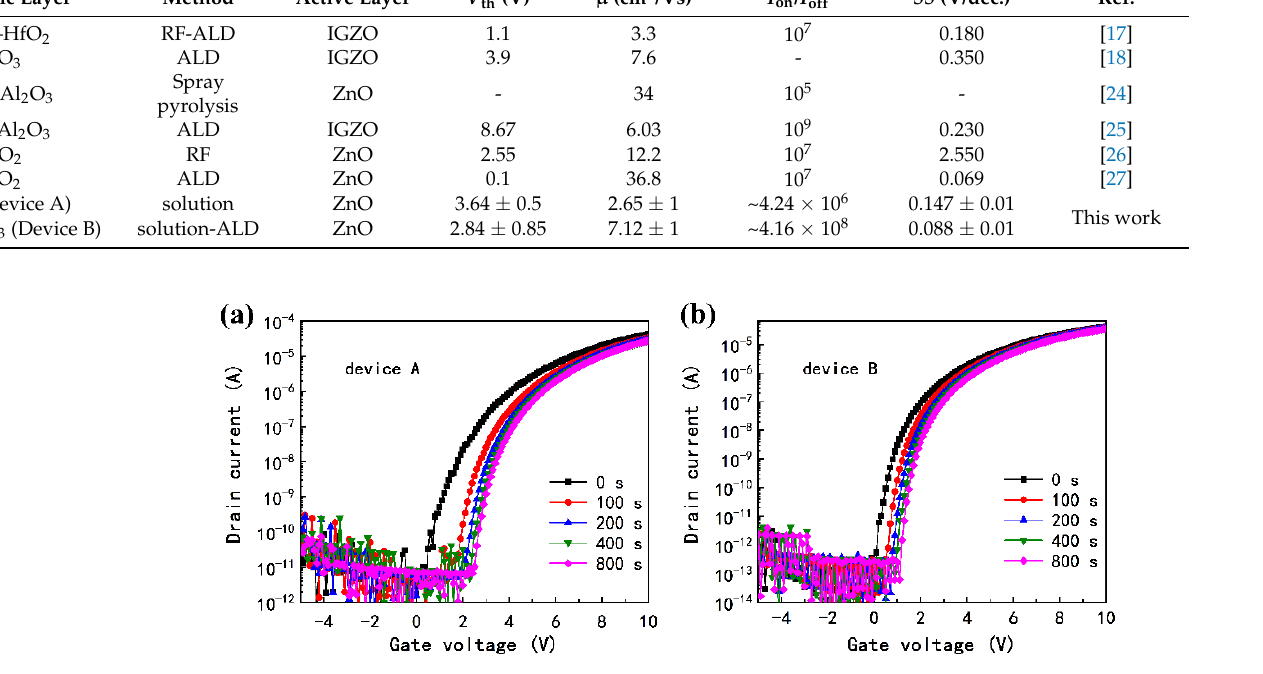
where V th is the initial threshold voltage, τ is the carrier trapping time, and β is the stretch index. The τ values of the Y 2 O 3 dielectric layer and the Y 2 O 3 –Al 2 O 3 laminated dielectric layer of the ZnO TFT extracted from the equation are 1.60 × 10 5 and 7.47 × 10 5 s, and the β value is 0.21 and 0.41, respectively. An oxide TFT device with a high τ value has better stability, so the failure time of a ZnO TFT device with an Y 2 O 3 –Al 2 O 3 laminated dielectric layer is Figure 5. ( a ) Positive bias stress of device A and ( b ) Positive bias stress of device B.